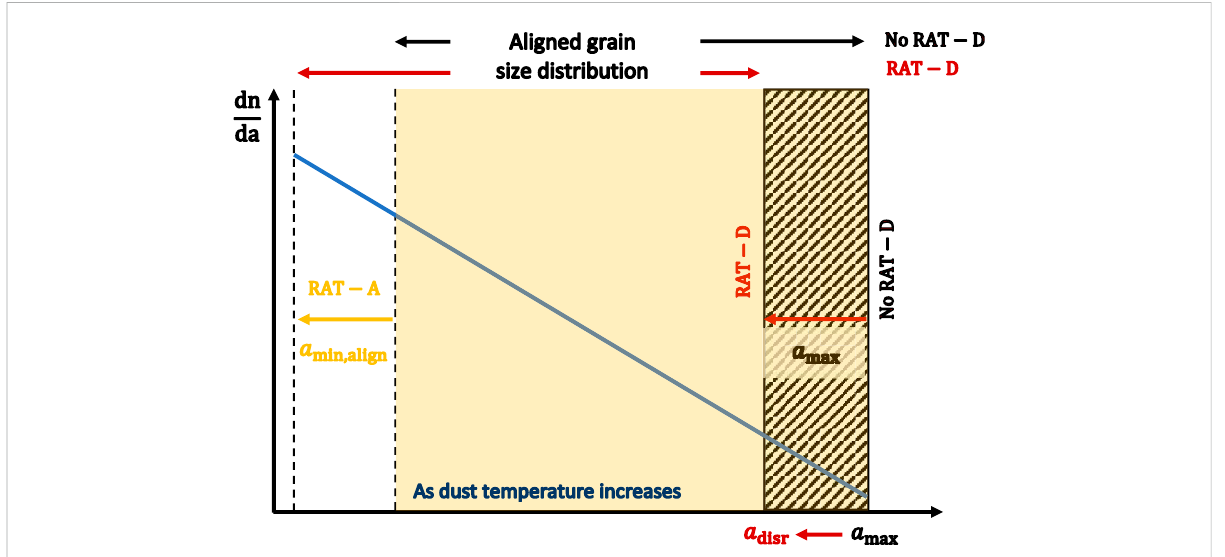
FIGURE 7 Understandingofthermaldustpolarization.Fora fi xedmaximumgrainsize( a max ),higher radiationstrength/dusttemperaturecanbringsmaller grains to align (smaller size of a min,align ) so that the aligned grain size distribution becomes broader. This broad size distribution increases the degree of thermal dust polarization with radiation strength/dust temperature. If the maximum grain size is determined by the RAT-D mechanism and grains are composite ( a max → a disr ), higher radiation/dust temperature results in smaller a disr . The consequent narrower aligned grain size distribution drops the polarization